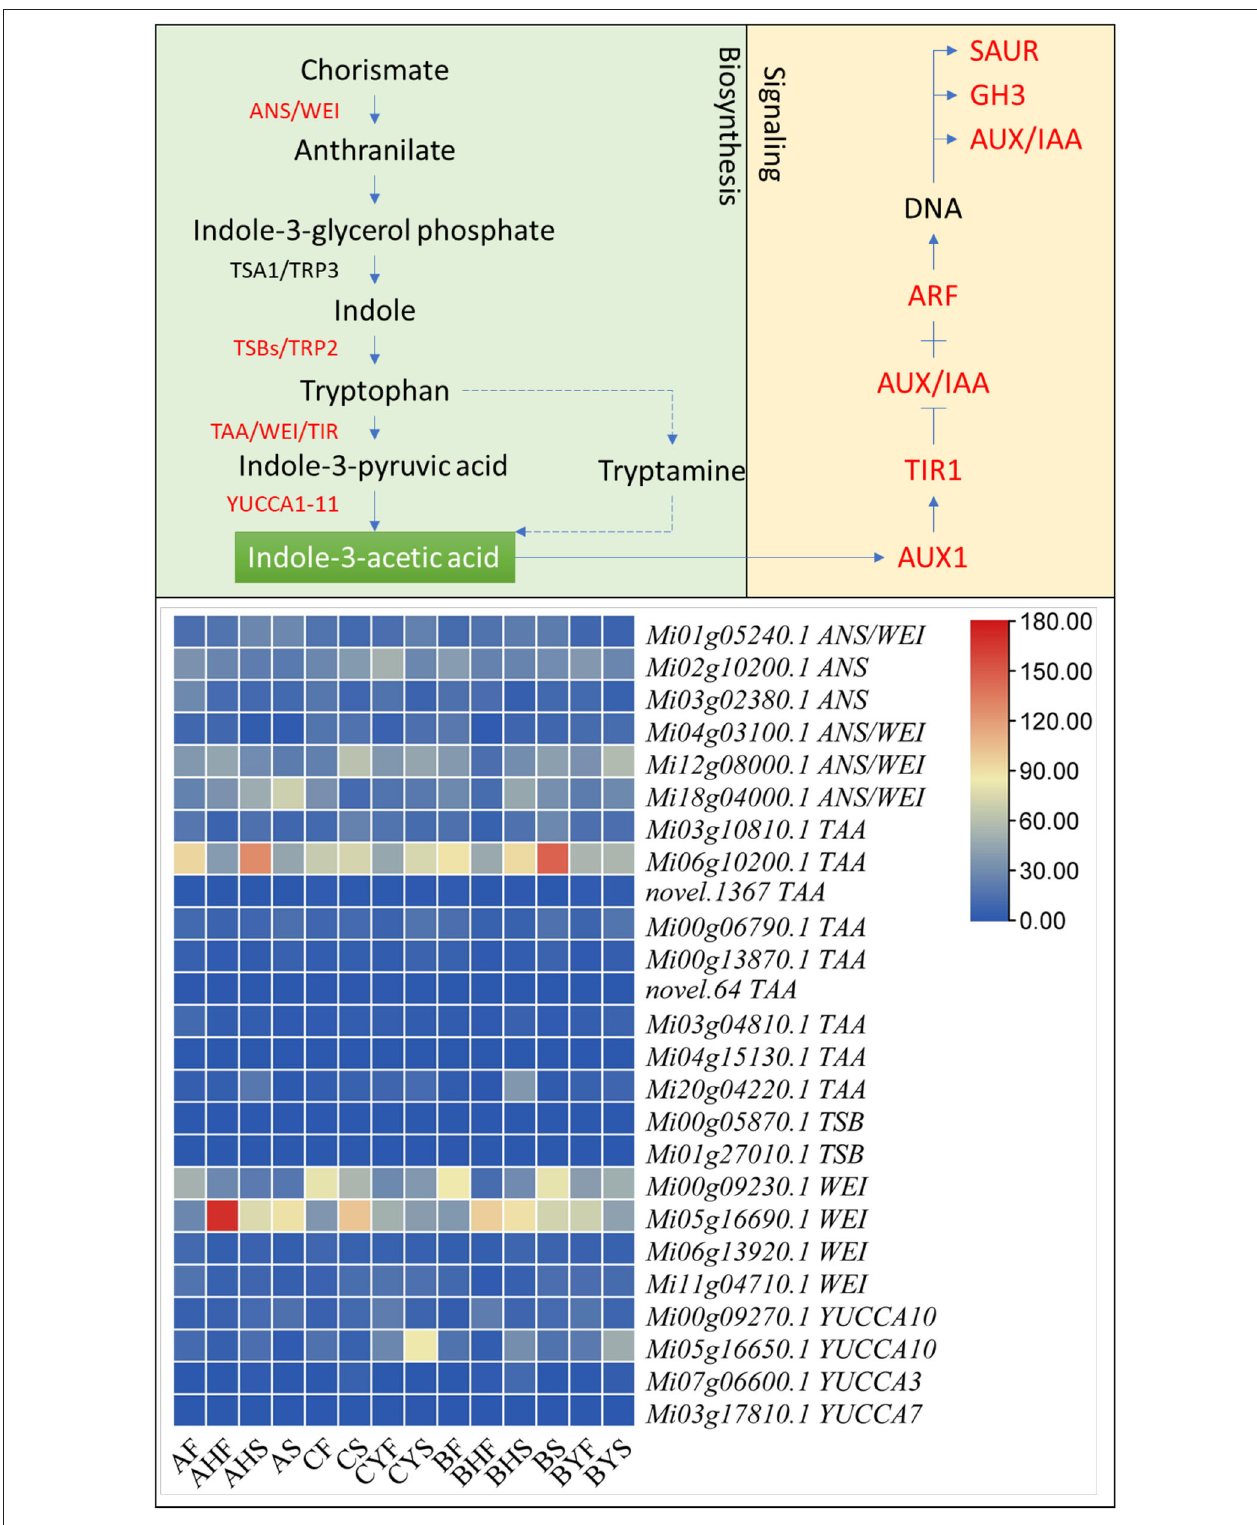
FIGURE 5 | Indole-3-acetic acid biosynthesis and auxin signaling in mango. The red text shows differentially expressed genes. ANS, anthranilate synthase; WEI, weak ethylene insensitive; TSB. Tryptophan synthase beta chain; TAA, tryptophan aminotransferase; YUCCA, YUC flavin-containing monooxygenase; AUX1, auxin influx carrier; TIR1, F-box transport inhibitor response 1; Aux/IAA, auxin/indole-3-acetic acid; ARF, auxin response factor; SAUR, SAUR family protein; GH3, auxin-responsive GH3 family. The heatmap represents the FPKM values of the transcripts. The sample names are given as per Table 1 .